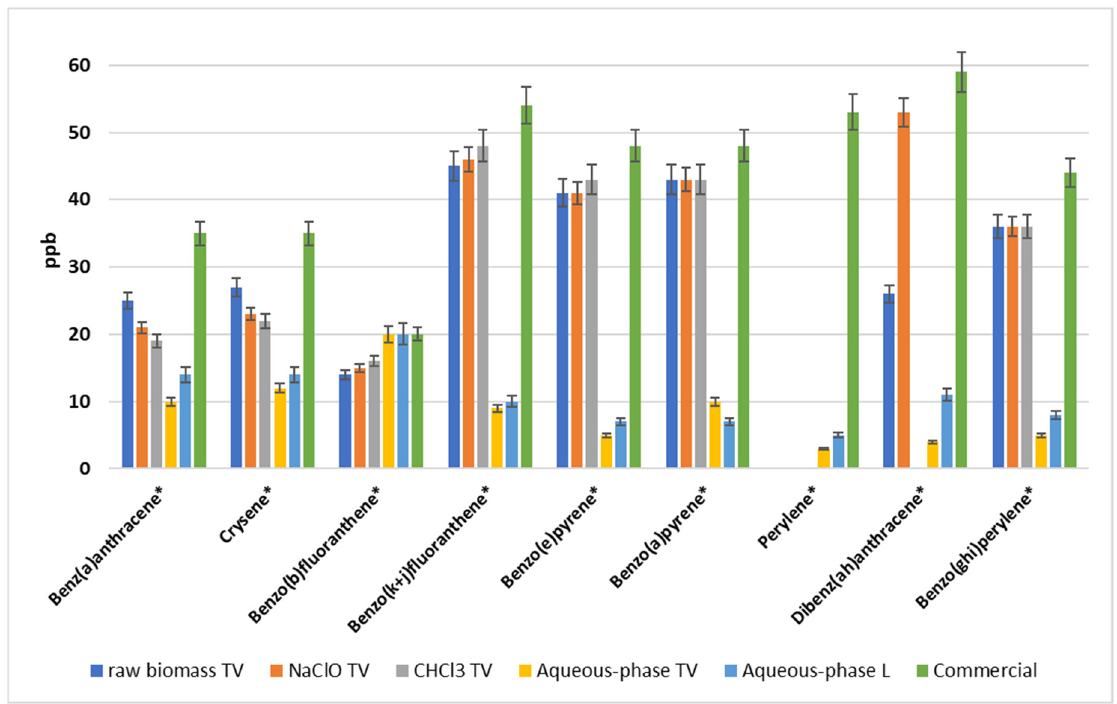
Figure 2. Concentration of PAHs in PHA samples of different origins and after different extraction methods. Limits for these starred PAHs are reported in the European Regulation EC/1907/2006 [21].